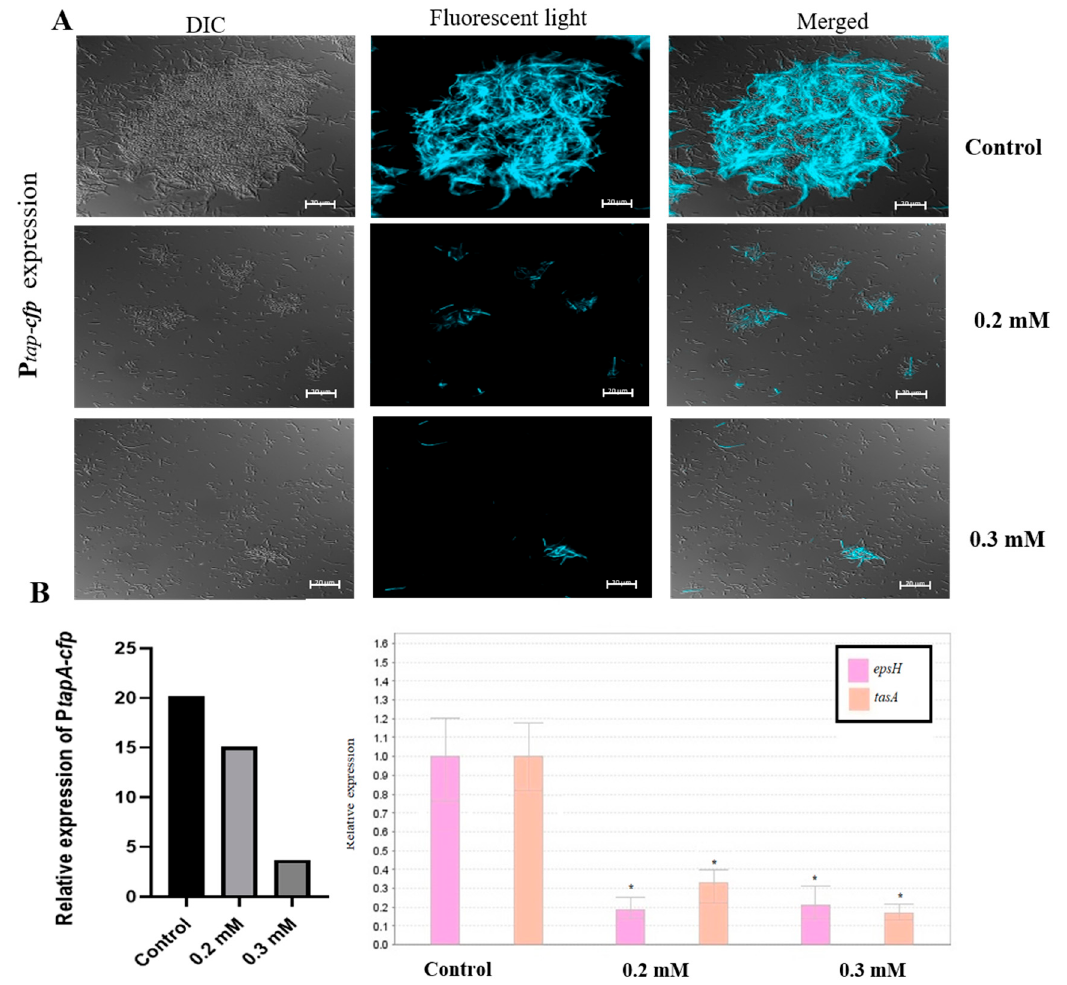
Figure 2. Zn 2+ ions downregulate the expression of genes responsible for extracellular matrix production in B. subtilis biofilm. Shown by inverted florescence microscope images of B. subtilis cells bearing the P tap ‐ cfp transcriptional fusion ( A ), measurement of cyan fluorescent protein (CFP) fluorescence intensity, and relative expression of epsH and tasA genes using real time RT ‐ PCR analysis ( B ), following overnight incubation in LB supplemented with 3% lactose at 23 °C (with 50 rpm shaking), with or without the presence of ZnCl 2 . Scale bar—20 μ m. * p ‐ value < 0.05 for comparing with control.